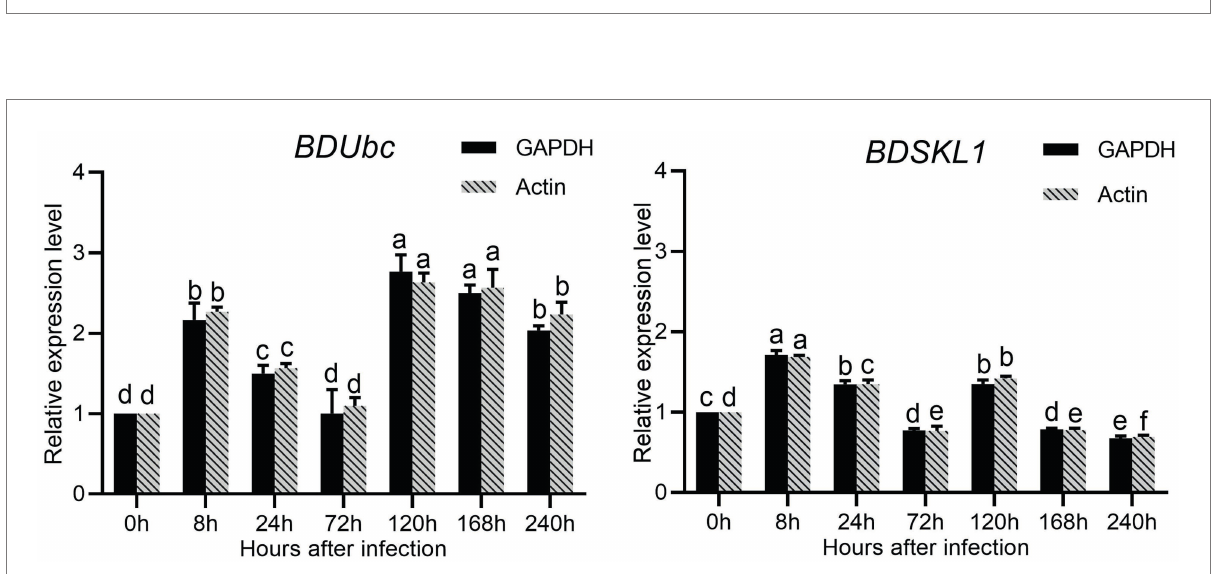
FIGURE 8 Relative expression levels of BDUbc and BDSKL1 .There are significant differences in the relative expression of different lowercase letters ( p <